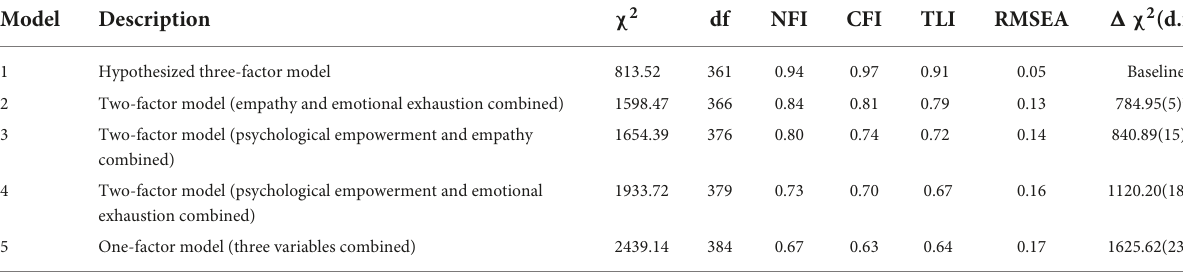
TABLE 2 The results of confirmatory factor